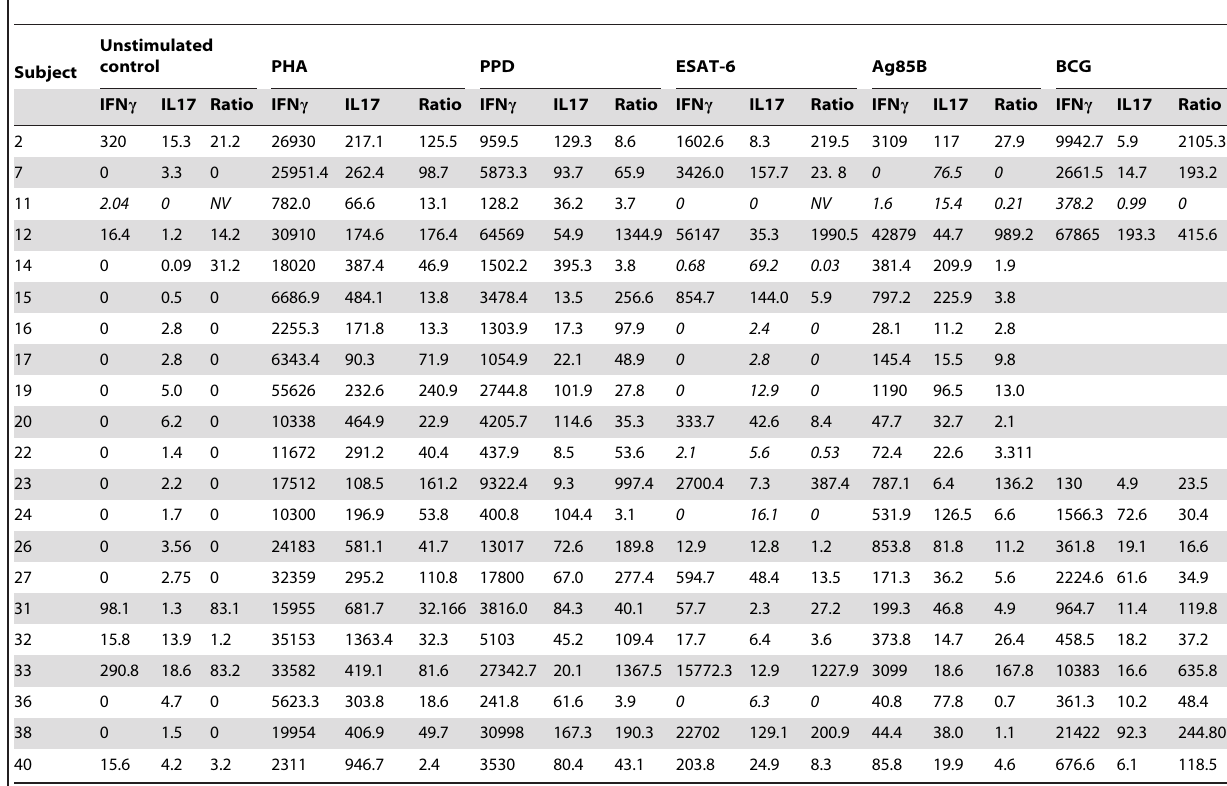
Table 1. IFN- c and IL-17 responses in healthy TST-positive